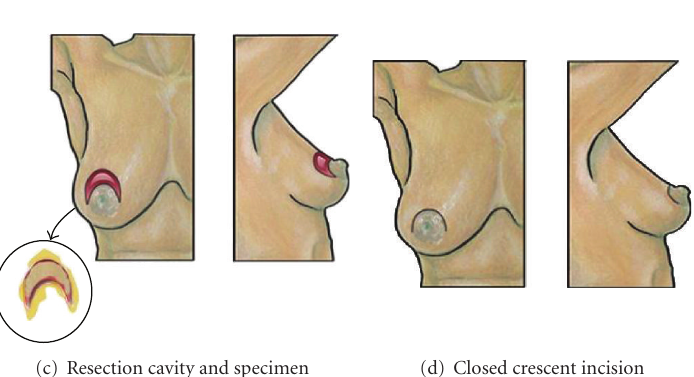
Figure 4: Crescent Mastopexy. (a) Shows location of crescent mastopexy skin incision. (b) Shows multiple “stars” indicating possible tumor locations suitable for this approach. (c) Shows resection cavity following excision of malignancy with excised specimen (inset). (d) Shows breast following closure of the skin incision.